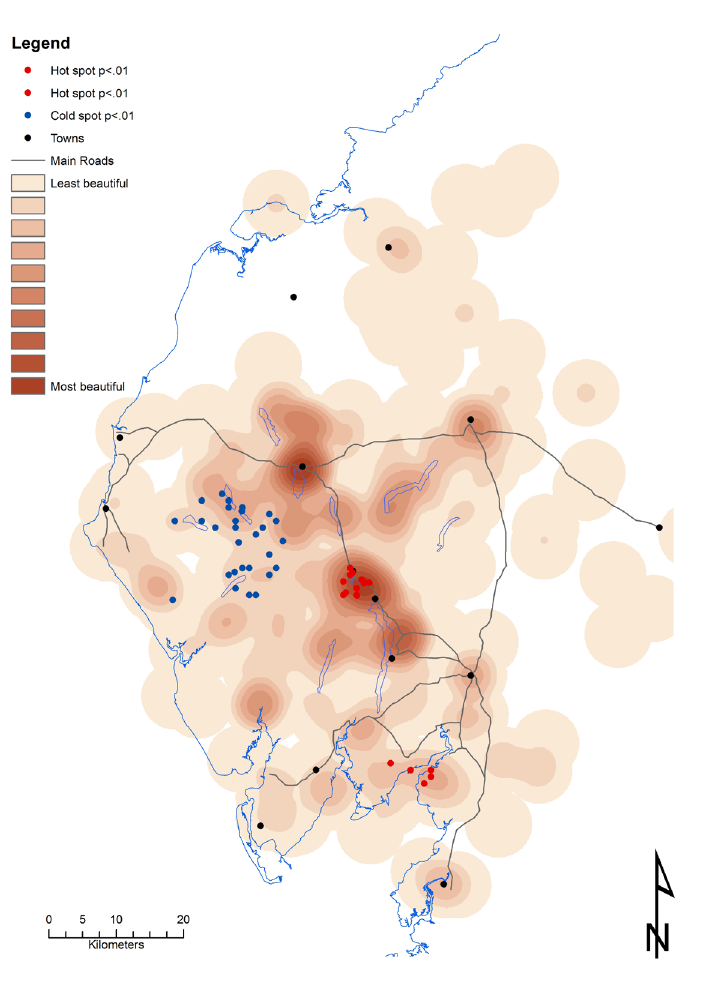
Figure 5: Places associated with the search-term ‘beautiful’ in the Lake District corpus. The overall distribution of place-names that occur in the same sentence as ‘beautiful’ are shown as the smoothed brown surface. Places the occur near to ‘beautiful’ more or less frequently than would be expected from the overall distribution of place-names within the corpus are shown as red and blue dots